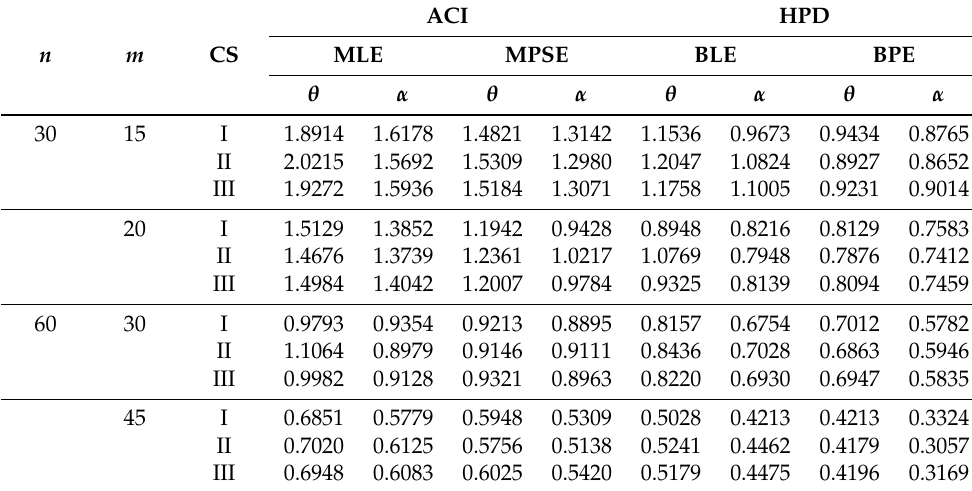
Table 2. The AWs for the model parameters at ( α , θ ) = ( 1.4,1.0 )